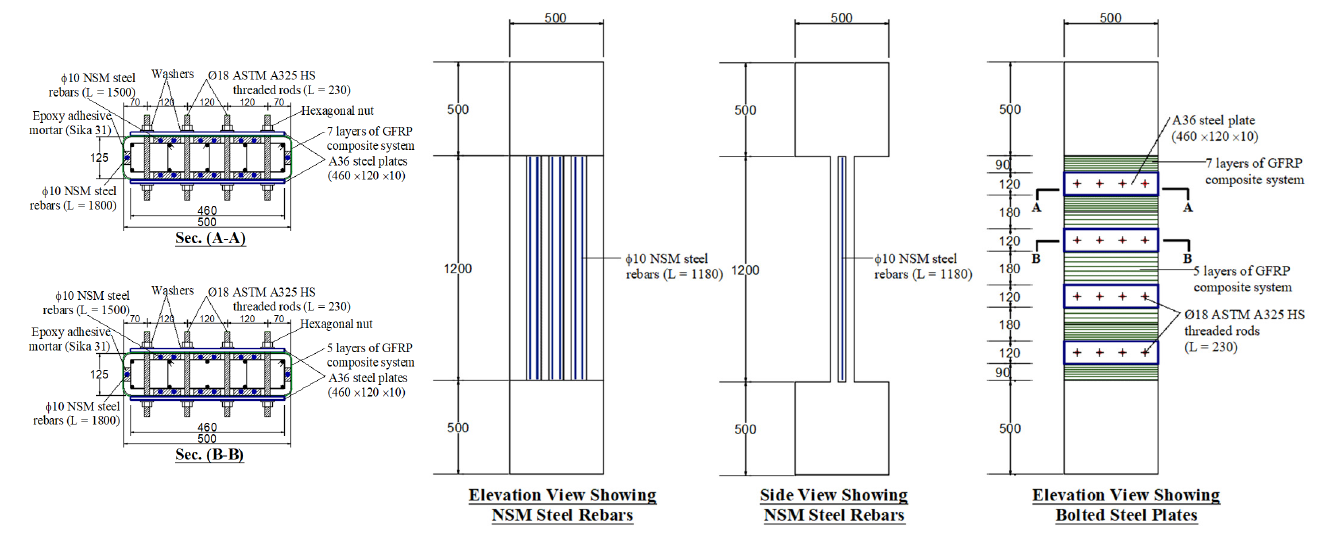
Figure 5. Details of strengthened column S4 (units of dimensions = mm).